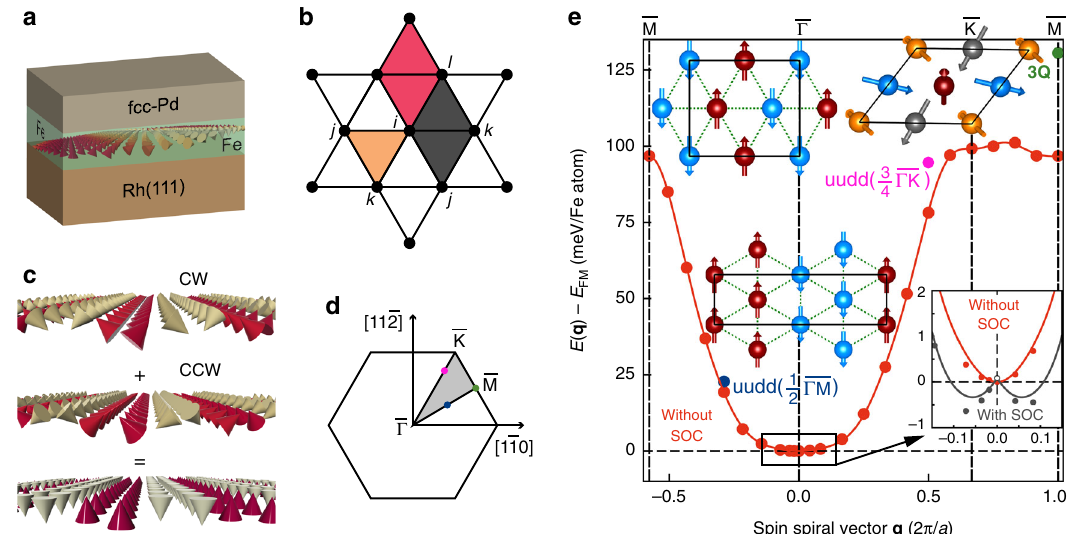
Fig. 1 Higher-order exchange interactions and multi-Q states. a Illustration of the Pd/Fe/Rh(111) ultrathin fi lm with a spin spiral propagating in the Fe layer. b Four sites ( ijkl ) involved in the four-site four spin interaction form a diamond (red and brown) on a 2D hexagonal lattice and three sites ( ijk ) involved in the three-site four spin interaction result in a triangle (yellow). A total of 12 diamonds and 6 triangles are possible for site i . The 12 diamonds can be categorized into two groups. One from each group is shown in red and brown. c Formation of an uudd state as a superposition of two 90 ∘ spin spirals with opposite rotational sense, i.e., clockwise (CW) and counterclockwise (CCW). d 2D Brillouin zone with two high symmetry direction Γ K and Γ M. The q vectors corresponding to the uudd state along Γ K (pink fi lled circle) and along Γ M (blue fi lled circle) as well as the 3Q state at the M point (green fi lled circle) are indicated. e Energy dispersion E ( q ) of homogeneous spin spirals of Pd/Fe/Rh(111). The fi lled circles (red) are DFT total energies without spin- orbit coupling (SOC). The solid line is a fi t to the Heisenberg model ( fi rst term of Equation (1)). The energies of the uudd state along Γ K (pink fi lled circle), the uudd state along the Γ M direction (blue fi lled circle) and the 3Q state (green fi lled circle) are denoted at the q value of the corresponding single-Q state. The spin structures of the uudd state along Γ K (pink), which is formed by a superposition of two 90° spin spirals at q = ± ð 3 = 4 Þ Γ K, the uudd state along the Γ M direction (blue), which is formed by a superposition of two 90° spin spirals at q = ± ð 1 = 2 Þ Γ M, and the 3Q state (green), which is a superposition of three spin spirals corresponding to three M points (green) in 2DBZ. Inset of e shows a zoom around the Γ point. Red circles denote DFT calculations without SOC and black circles calculations including SOC, i.e., the effect of DMI and MAE. The energetically lowest state is a spin spiral with a period of